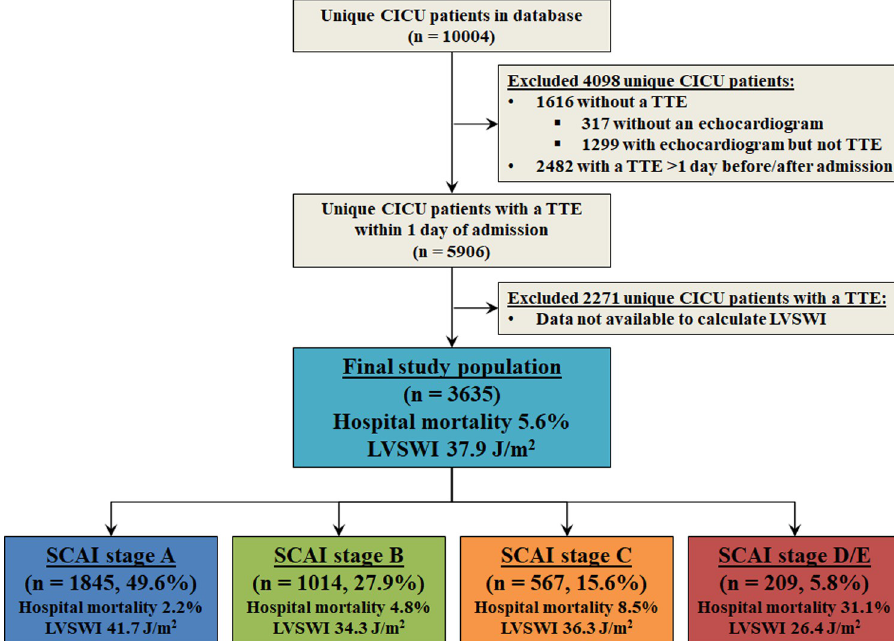
Fig 2. Flow diagram showing study inclusion and exclusion criteria. CICU, cardiac intensive care unit; LVSWI, left ventricular stroke work index; SCAI, Society for cardiovascular Angiography and Intervention; TTE, transthoracic